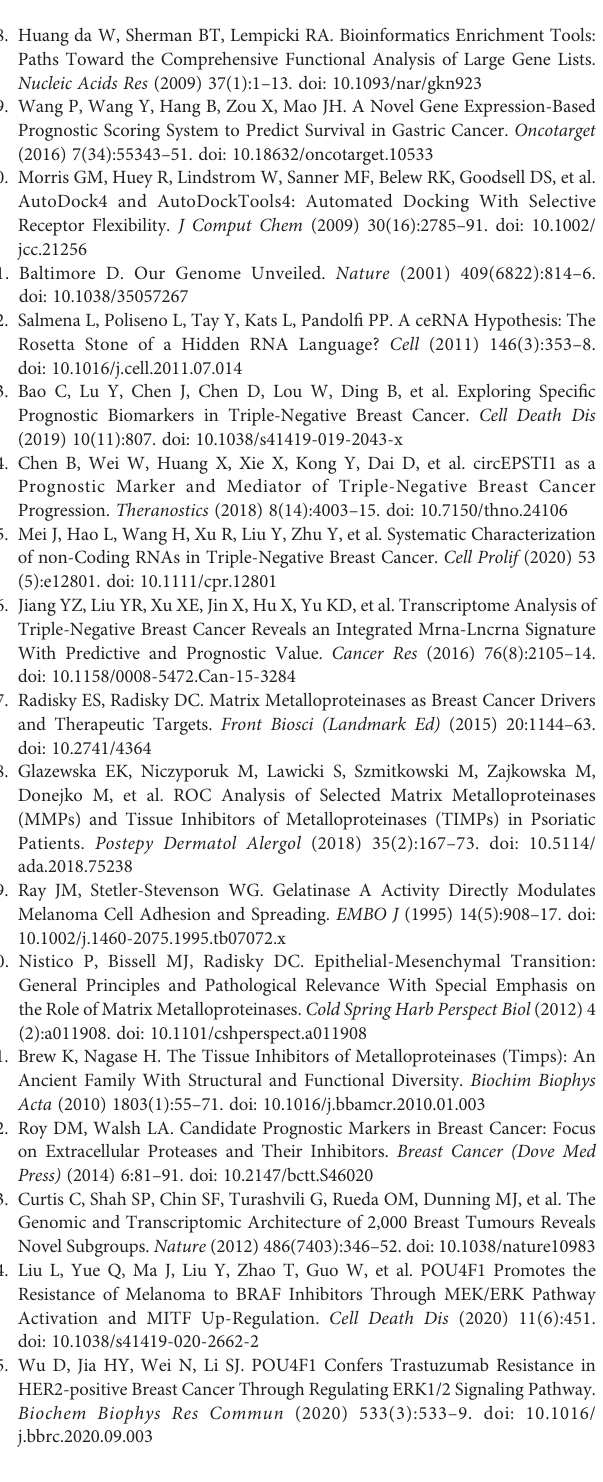
Supplementary Table 5 | mRNAs in ceRNA network associated with survival prognosis. Supplementary Table 6 | PS score and grouping in training data set and veri fi cation data set.